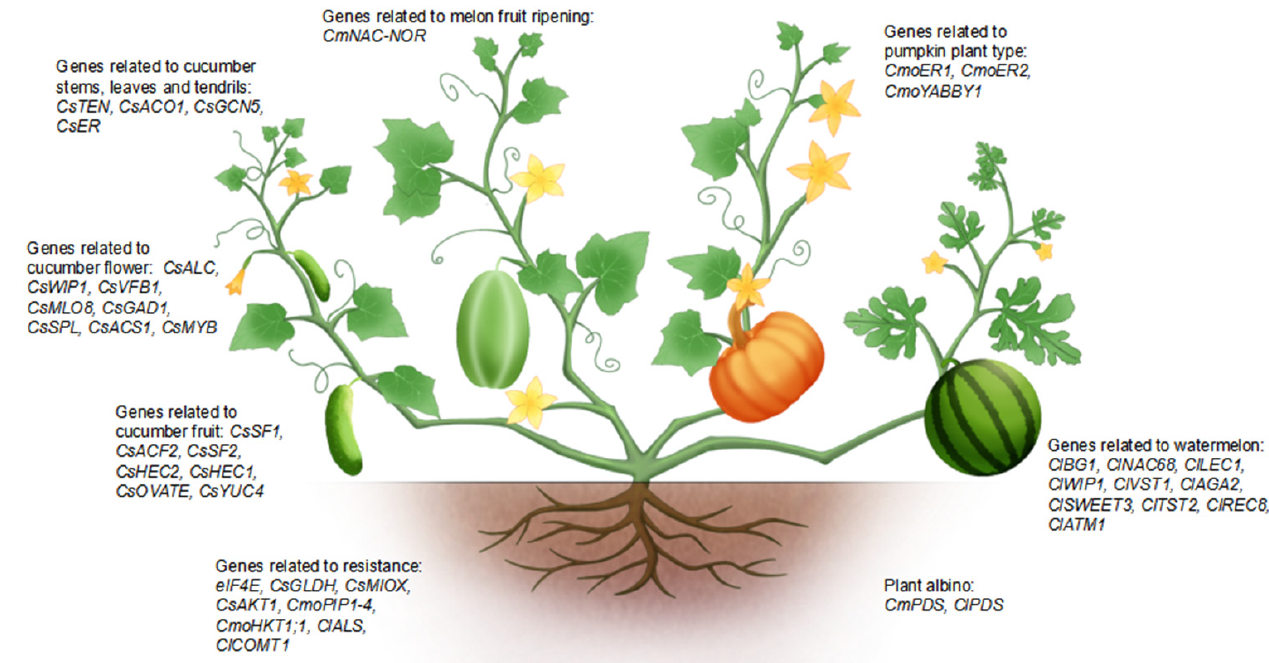
Figure 2. Illustration of editing genes in cucurbit crops. Table 2. Details of editing genes of cucurbit crops.